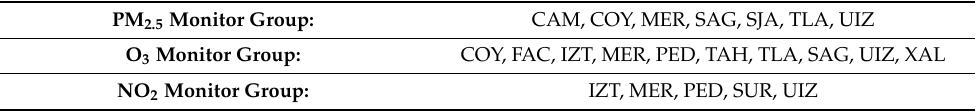
Figure A1. Monitoring locations in Mexico City and their abbreviated names. Table A1. Monitors included in determining average city-wide pollution concentrations in Mexico City from 2010 to 2015, by pollutant. Monitors (identified by three-letter codes) included in each group had missing data inputted prior to averaging. Monitors are listed in alphabetically order and ordering does not imply any additional